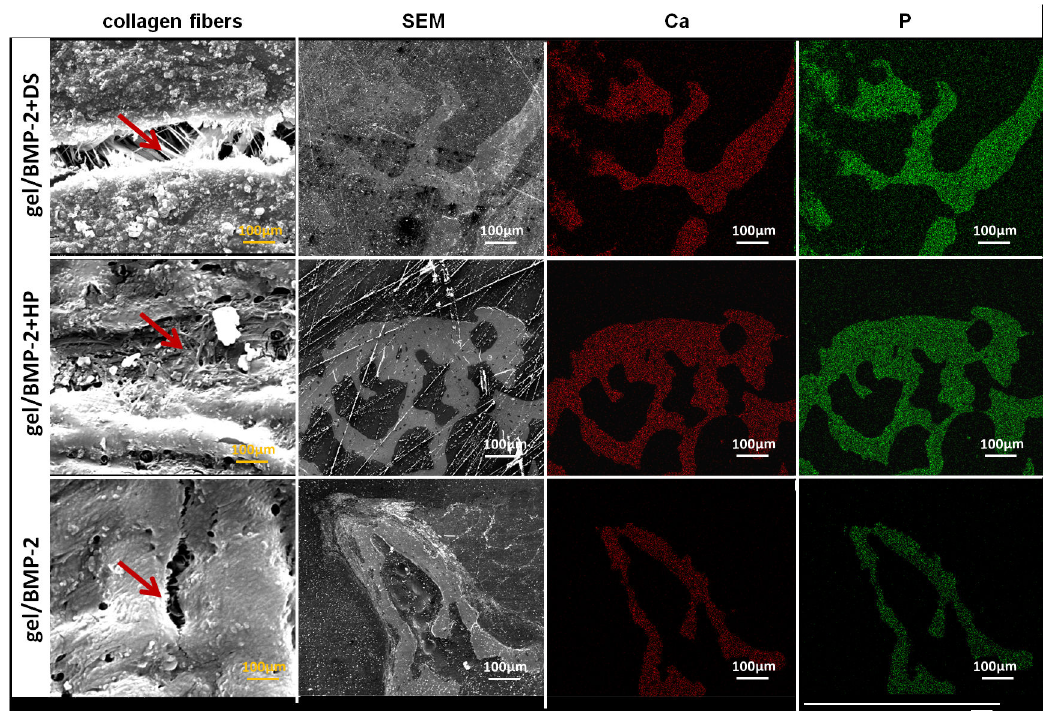
Figure 4. Six weeks following implantation, the ectopic bone formed by gel/BMP-2+DS, gel/BMP-2+HP and gel/BMP-2 was evaluated by histology via Masson’s Ttrichrome staining and osteocalcin (OC) immunostaining. B indicates a trabecular bone structure; nuclei were stained with